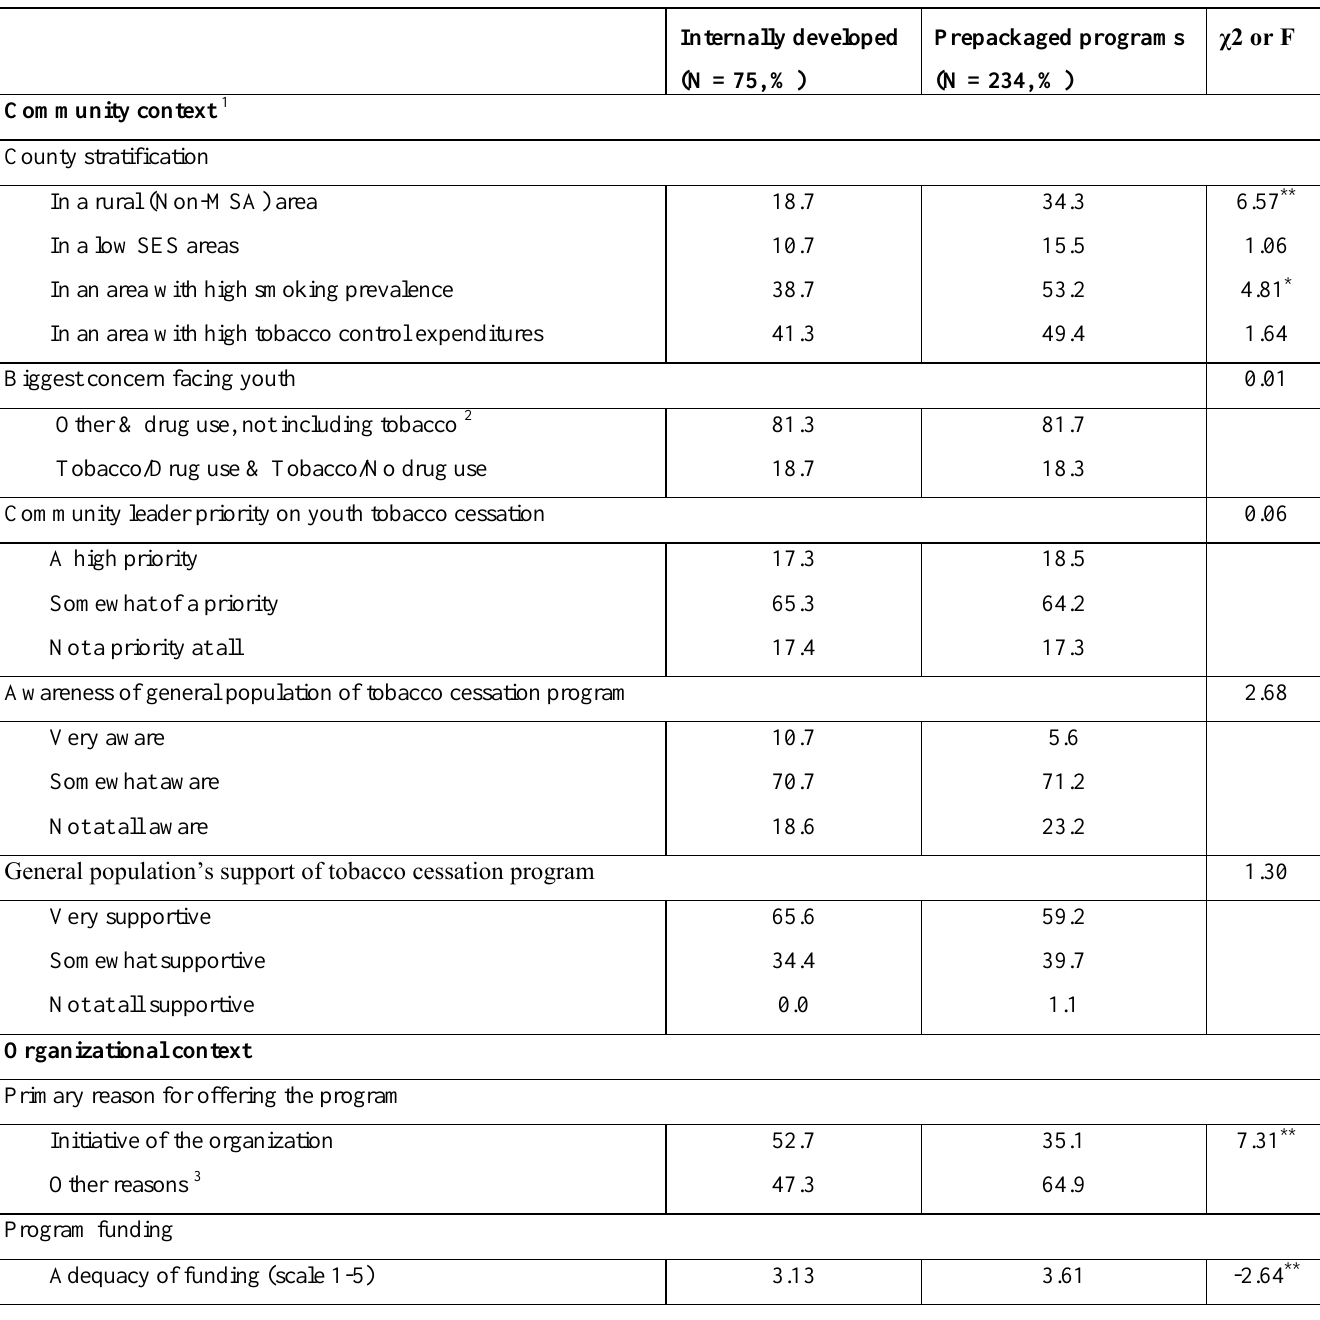
Table 1. Community and organizational context of internally-developed and prepackaged programs. Internally